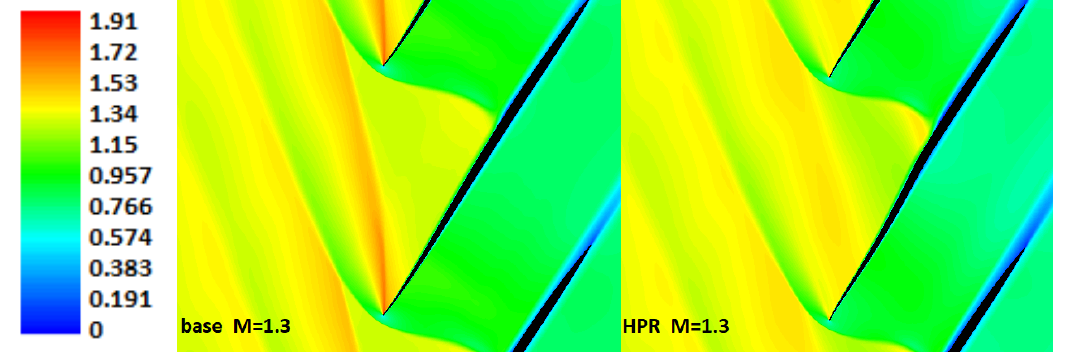
Figure 18. Mach contours of the profiles with HPR at Mach 1.3.